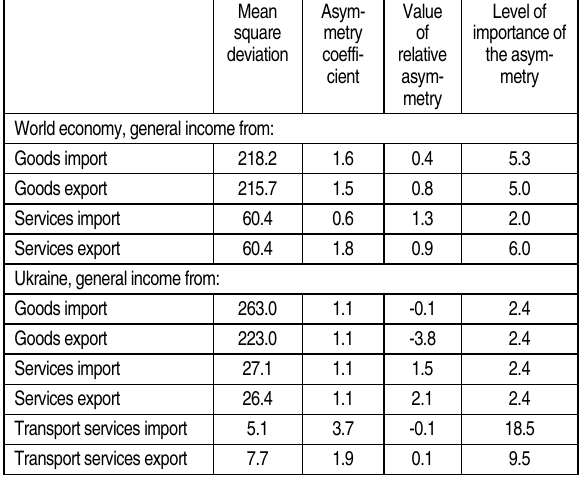
Table 7. Analyse results of asymmetry level of